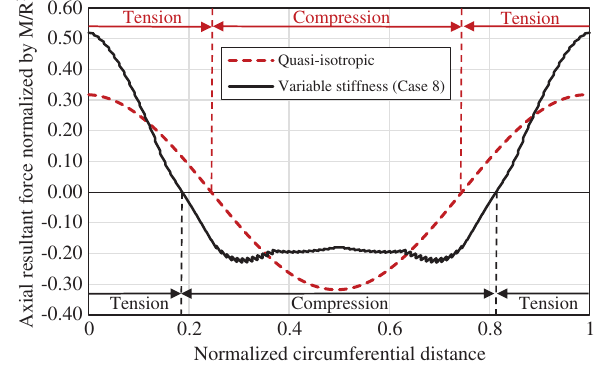
plies to get closer to 0 ° in the lower part (tensile side), but higher degrees (45 ° to 90 ° ) in the upper part (compres-